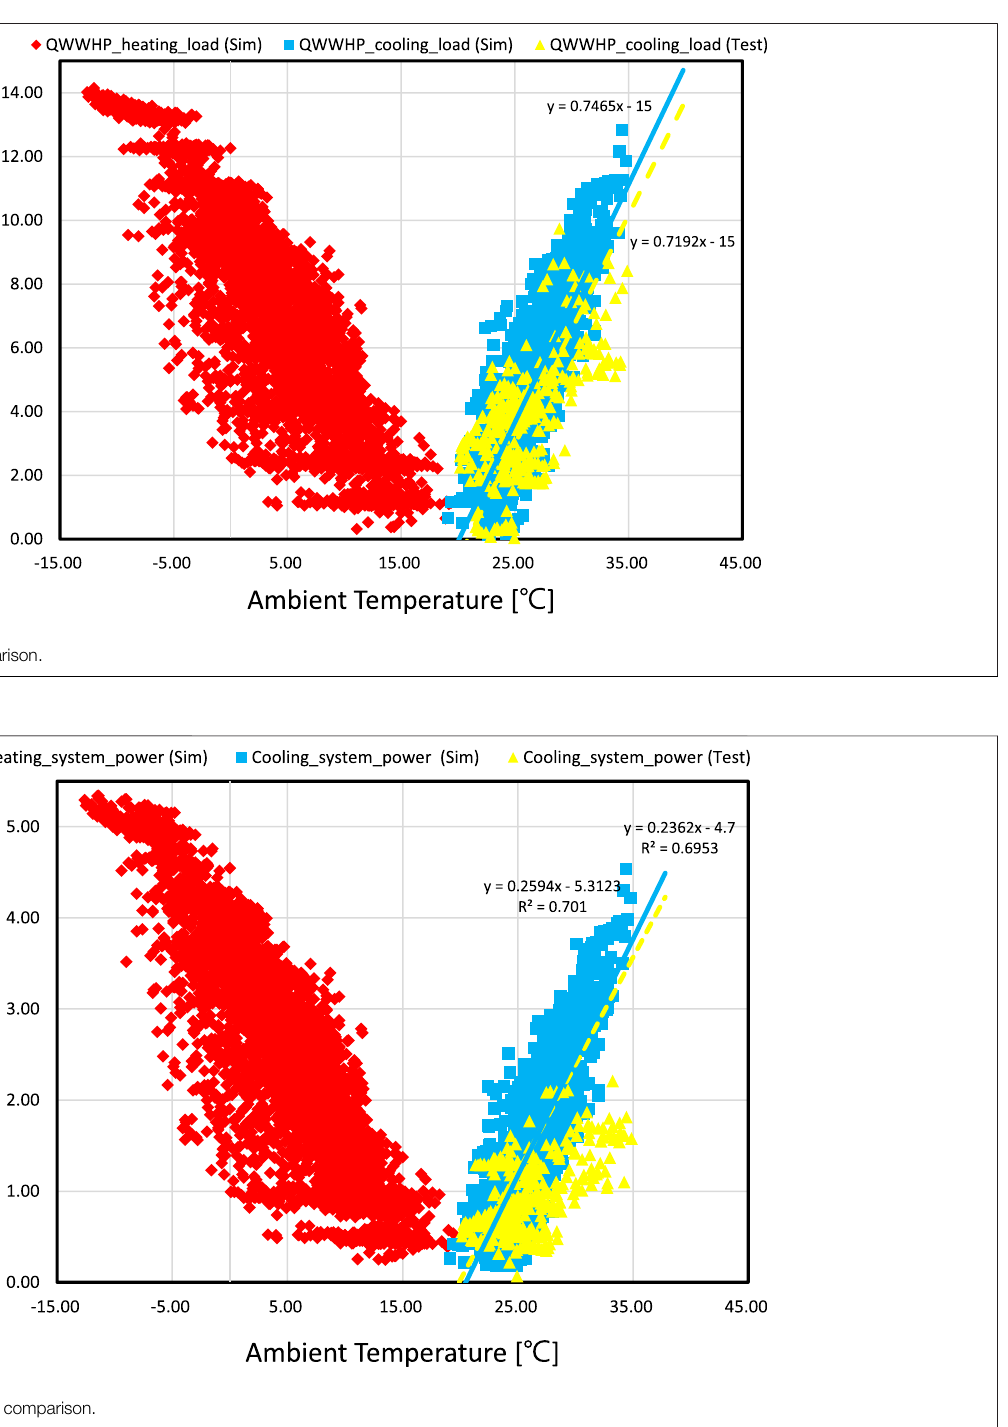
FIGURE 7 | Power consumption